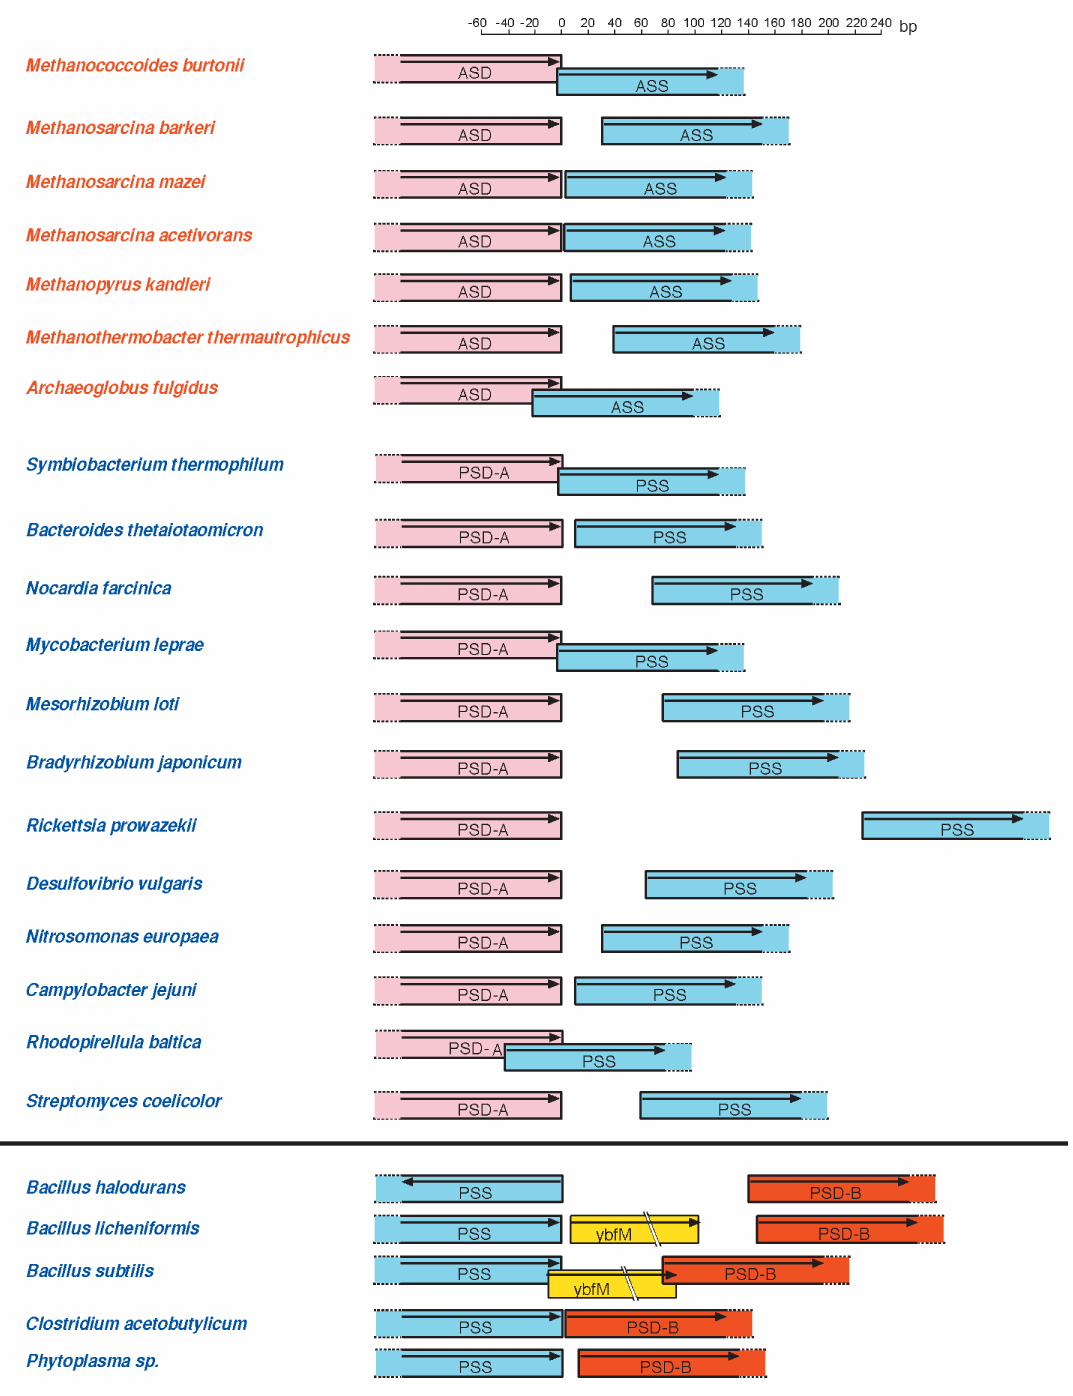
Figure 5. Arrangement of the archaetidylserine synthase/phosphatidylserine synthase (ASS/PSS) and archaetidylserine decarboxylase/phos- phatidylserine decarboxylase (ASD/PSD) genes. A light blue box indicates a gene or open reading frame (ORF) for ASS or PSS. The ORFs for ASD/PSD-A, PSD-B and ybfM are in pink, red and yellow boxes, respectively. The arrow in the box indicates the coding direction. The scale bar is shown at the top to express the sizes of the spacer regions between the genes. The central region of ybfM, an alkaline phosphatase homolog, is omitted. The sources are shown on the left side, and are colored red for Archaea and blue for